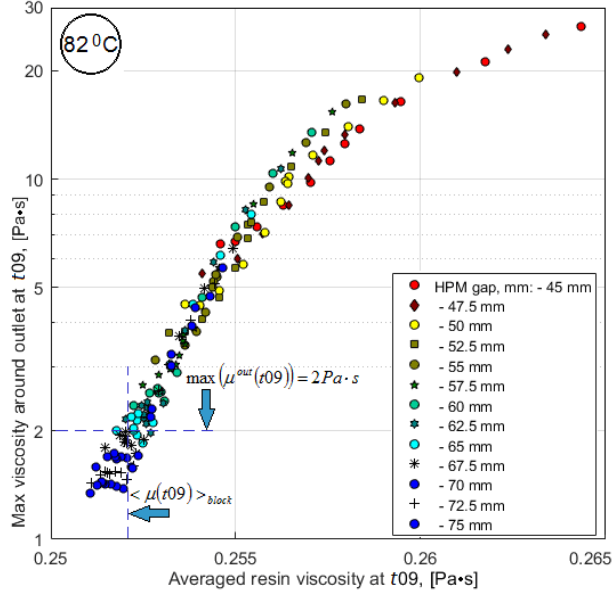
Figure 14. Interdependence between the averaged within the preform and maximum in the vicinity of the vacuum vent resin viscosities.